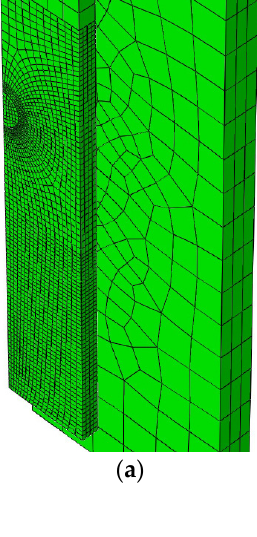
Figure 16. Adopted 3D mesh for 70 mm cover ( a ) and 15 mm cover ( b ) and symmetry conditions for 15 mm cover ( c ) and 70 mm cover ( d ) for the double-lap test.